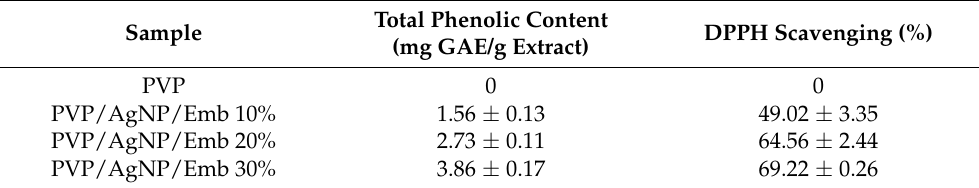
Table 1. Antioxidant activity and total phenolic content of neat PVP and dressing spray containing different amounts of Phyllanthus emblica